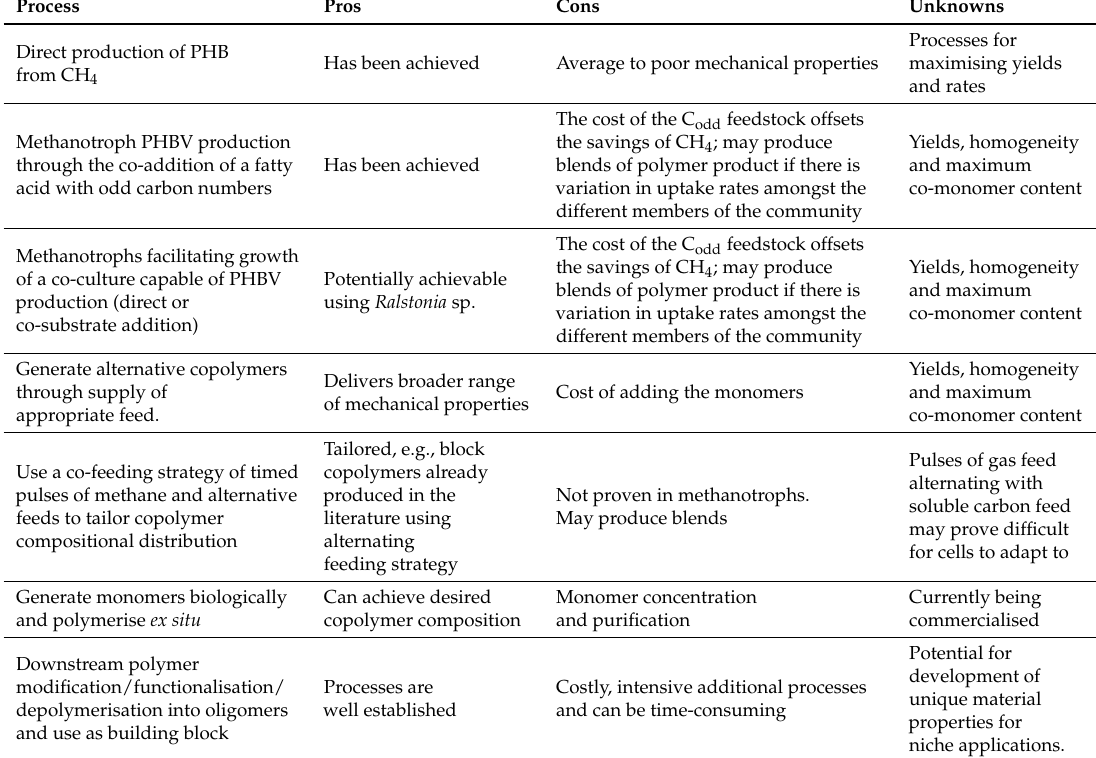
Table 3. Strategies for PHA and PHA derivative production using methane as the primary